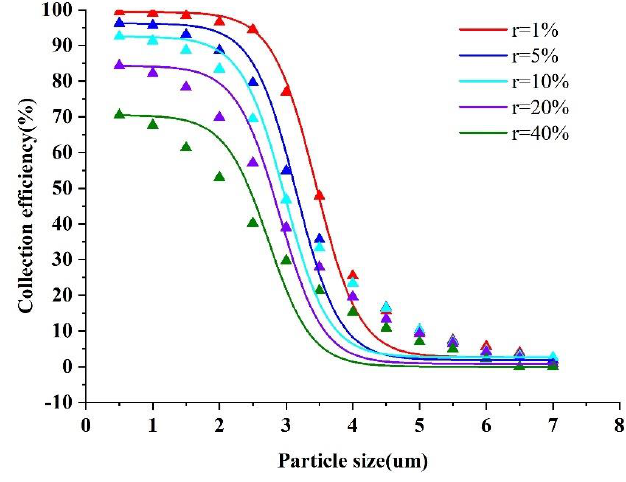
Figure 11. Collection efficiency curves at different split ratios (r) .